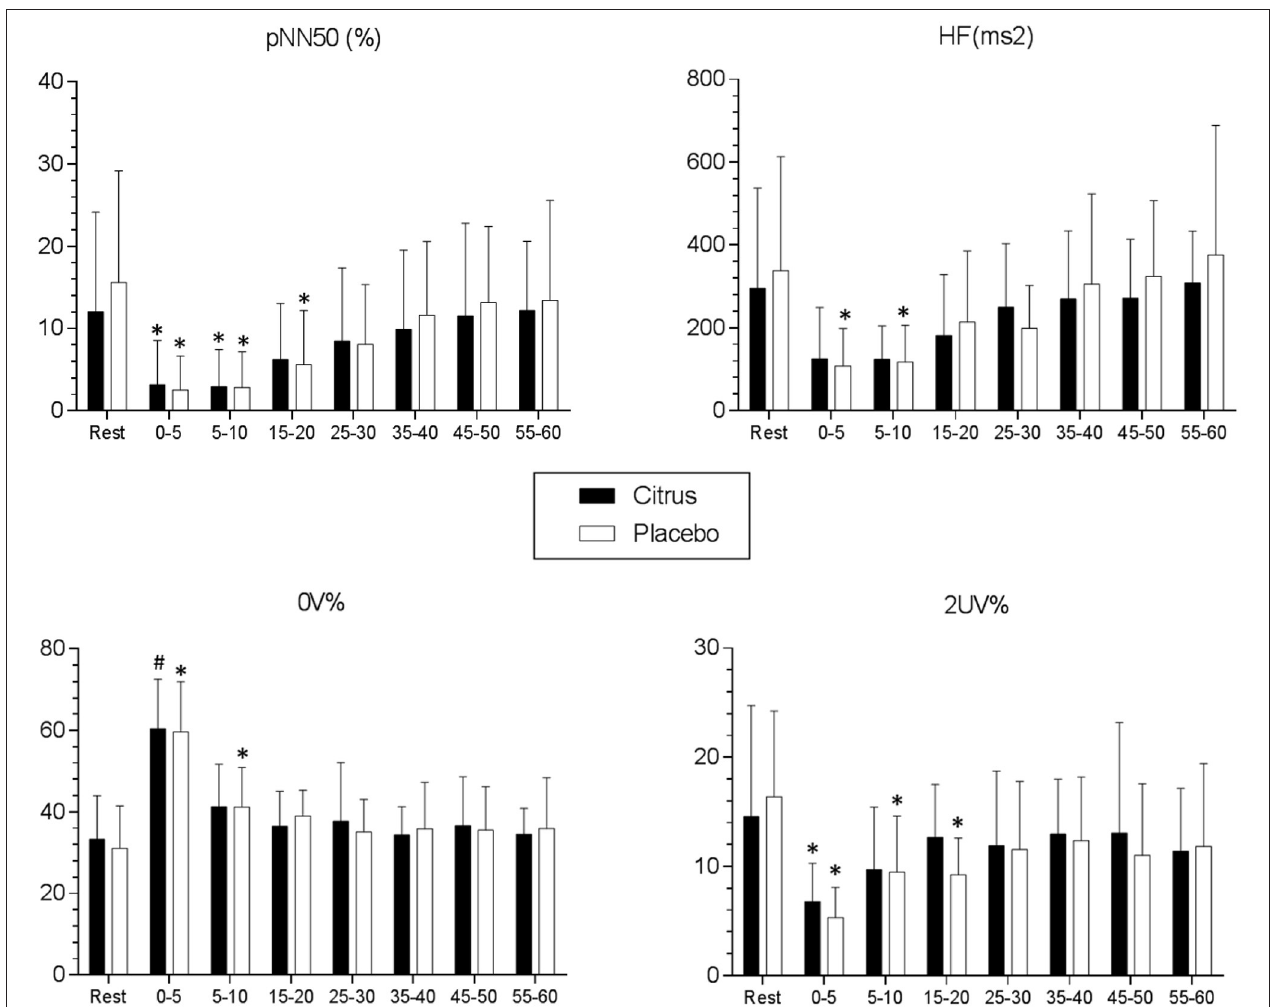
FIGURE 3 | Mean values and respective standard deviations of pNN50 (%), HF (ms 2 ), 0V% and 2UV% obtained at rest and during recovery from submaximal aerobic exercise. *Values with significant differences in relation to rest ( p < 0.05) (Friedman, Dunn’s post-test); # Values with significant differences in relation to rest ( p < 0.05) (ANOVA1, Bonferroni’s post-test); pNN50 (%): percentage of adjacent R-R intervals with a difference of duration > 50ms; HF (ms 2 ): High frequency spectrum (0.15–0.40Hz); 0V%: zero variations; 2 UV%: two unlike